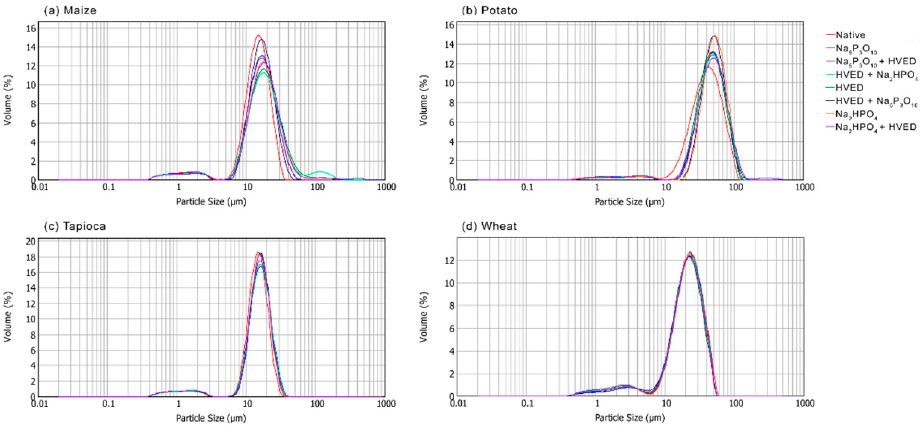
Figure 5. Particle size distribution of starches modified with high-voltage electrical discharge and phosphorylation.